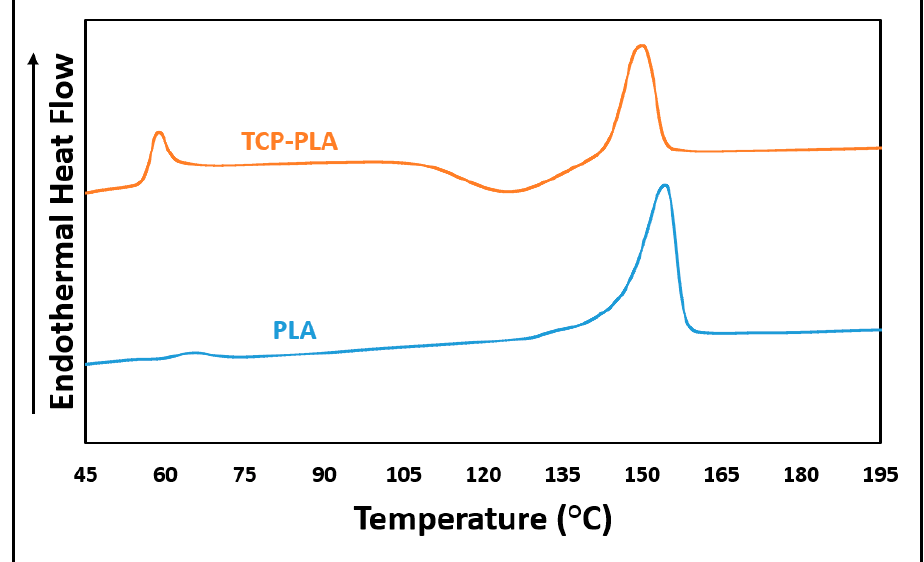
Figure 7. DSC results of PLA and TCP–PLA filaments. Table 1. Thermal properties of PLA and TCP–PLA filaments obtained from DSC.